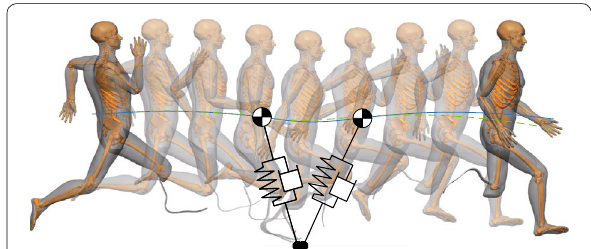
Fig. 4 Synthesized motion of ILEA sprinting using RSP (20 fps). Blue: measured center of mass (COM) trajectory; green: simulated COM trajectory